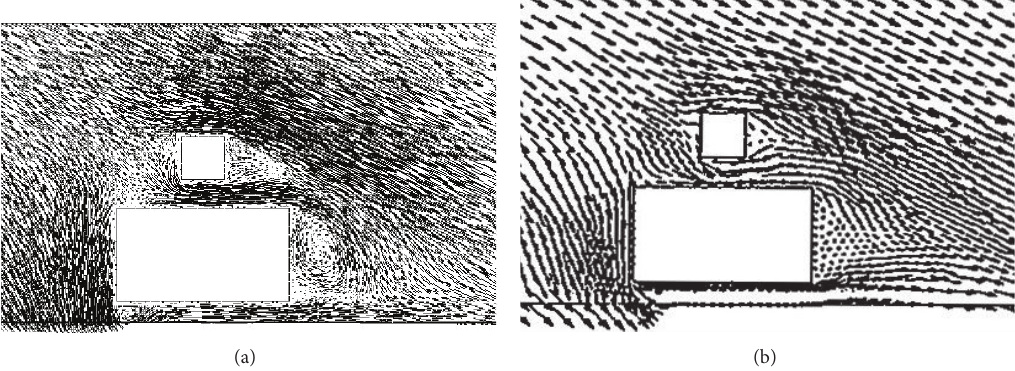
Figure 8: Velocity vectors around the AGV (a) current 3D results; (b) Kanayama et al.’s 2D results.